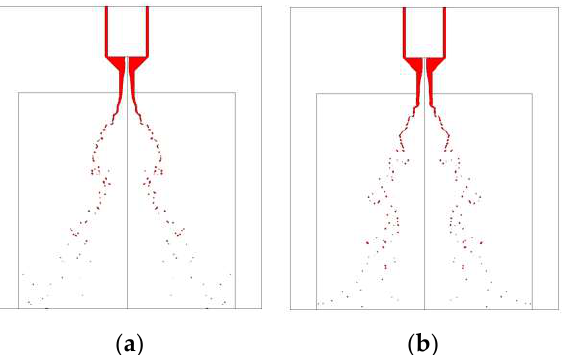
with downstream orifice plate and 0.15 mm stroke.